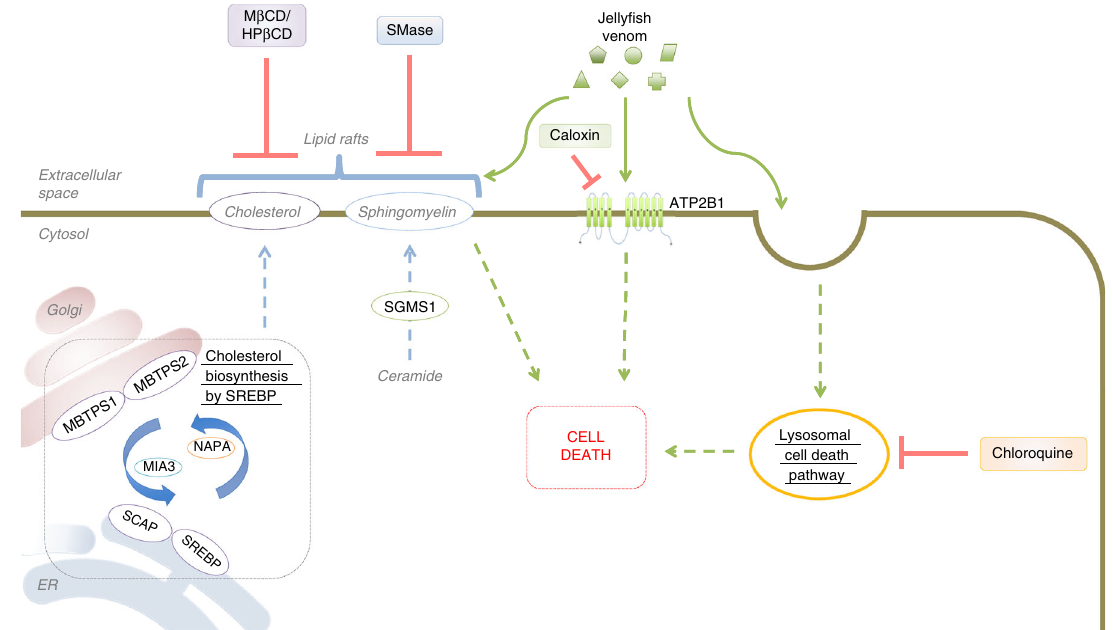
Fig. 8 Schematic representation of the cellular pathways of top hit genes detected by the jelly fi sh venom